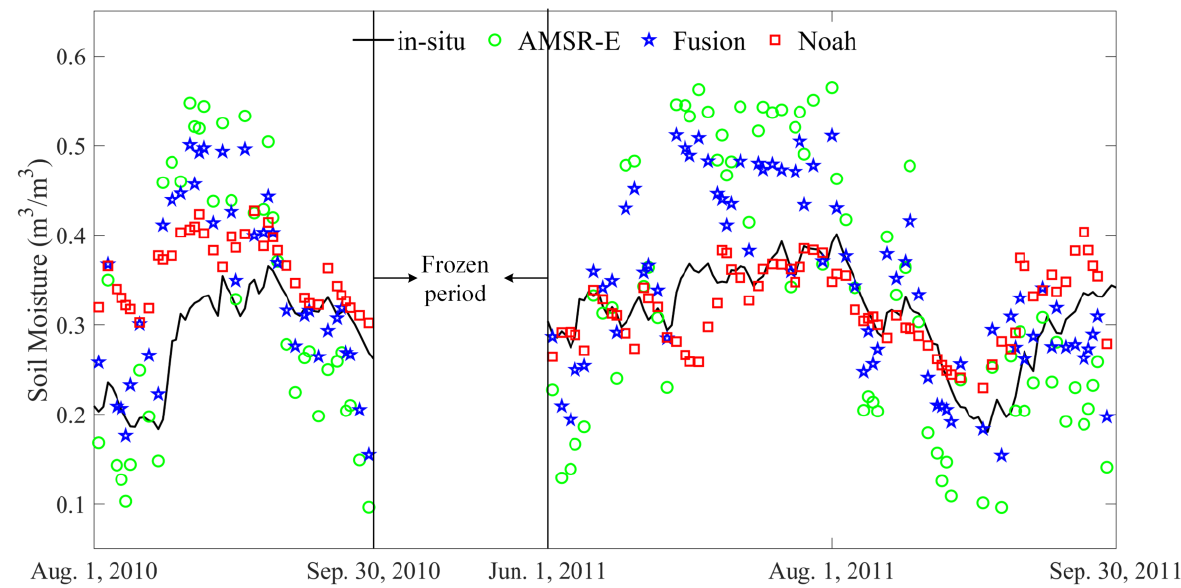
Figure 6. Comparison of the in situ, AMSR-E, Noah, and the fused MODIS SSM at SMTMN scale in unfrozen period. The gap between the two solid black lines is the frozen period. The in situ data are represented by line symbol and the pixel SSM is represented by point symbol.